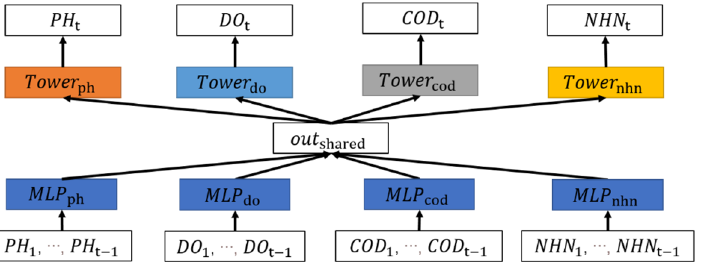
Figure 2. Hard parameter sharing structure of multi-indicator water quality prediction. The dark blue part represents the shared parameter layer, and the orange and yellow parts represent the models for different tasks forming the tower layer.